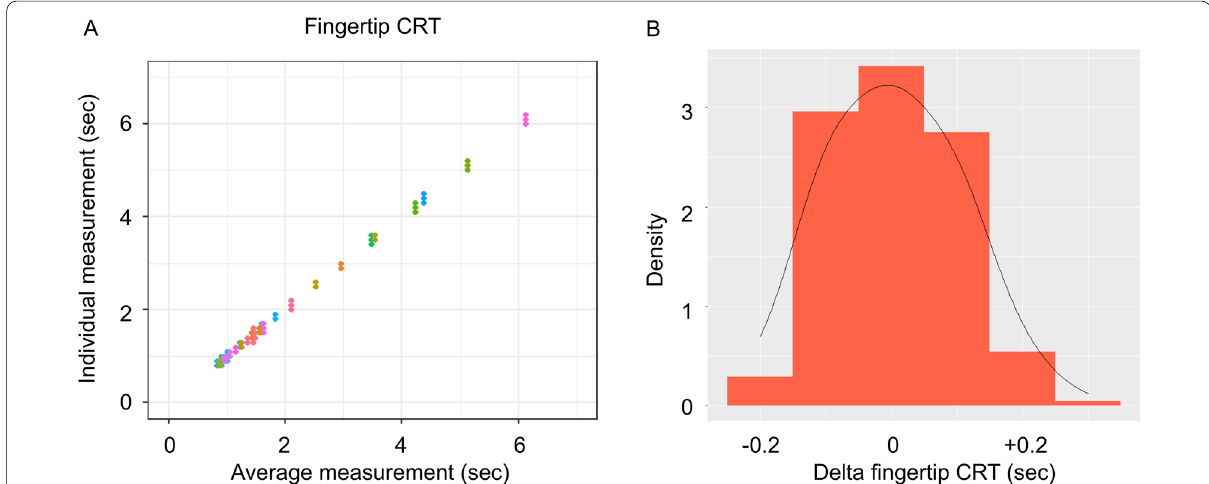
Fig. 1 A Individual and patient‑averaged repeated fingertip CRT measurements at a single timepoint (seconds). Data are color‑coded by patient. B Distribution of variations of fingertip CRT measurements